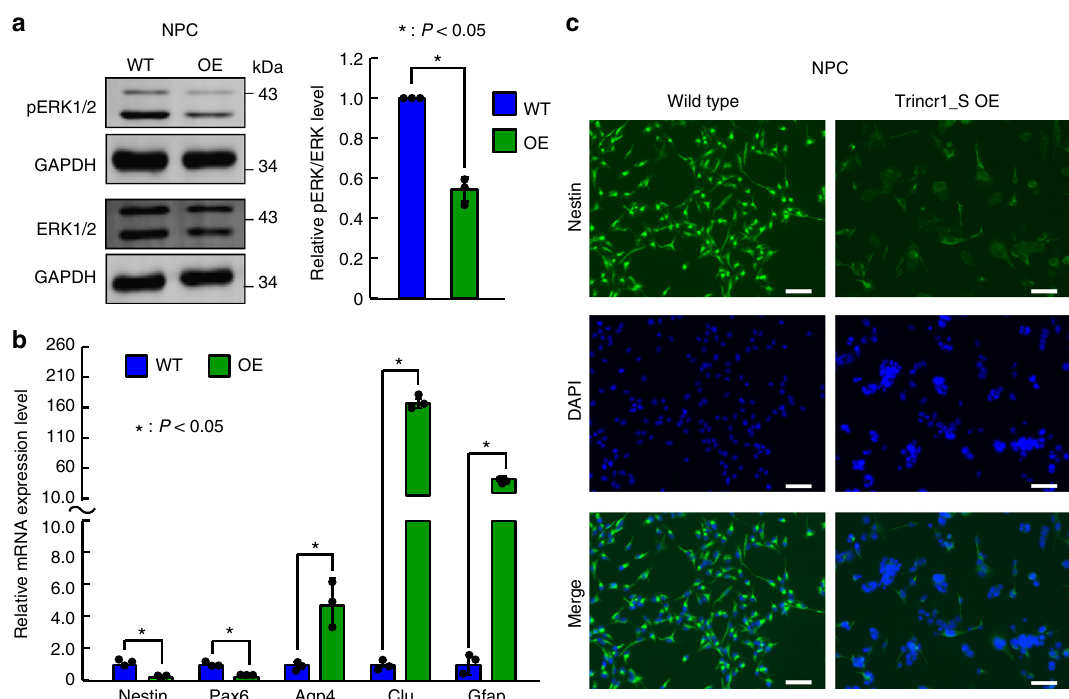
Fig. 7 Ectopic expression of Trincr1 represses FGF/ERK signaling in NPCs. a Western blotting analysis of pERK in NPCs overexpressing Trincr1_S. Shown are representative images (left) and quanti fi cation (right). Data were normalized to ERK and then to wild-type NPCs. n = 3 independent experiments. b RT- qPCR analysis of markers for NPCs and astrocytes. The β -actin gene was used as a control. Data were normalized to the mRNA level of wild-type NPCs. n = 3 biological replicates. c Immuno fl uorescence of Nestin in wild type and Trincr1_S overexpressing NPCs. Green represents Nestin, Blue represents DAPI. Scale bars, 100 μ m. Shown are mean ± SD. For a , P values were determined by paired two-sided Student ’ s t -test. For b , P- values were determined by unpaired two-sided Student ’ s t FLAG T2A GFP sequence. After transfection, CRISPR knockin ESCs were obtained after selection for 2 weeks under 1 μ g per ml puromycin and characterized by genomic PCR and sequencing. The primers for genomic PCR locate outside of 5 ′ arm and 3 ′ arm as shown in Supplementary Figure 6c. The expected PCR products